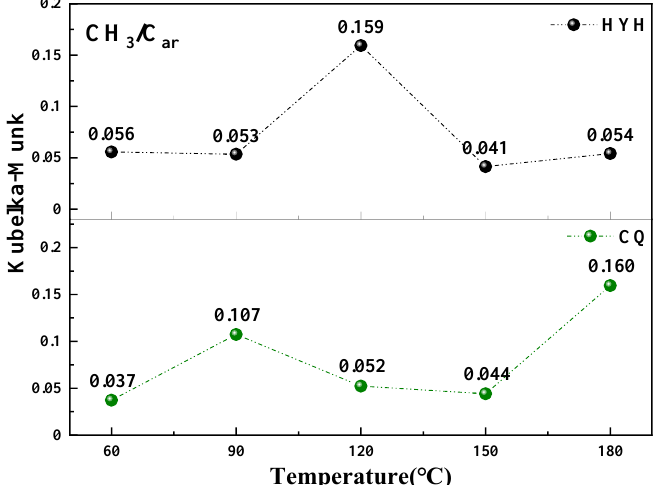
Figure 12. Diagrams of peak fitting based on the FTIR spectra.